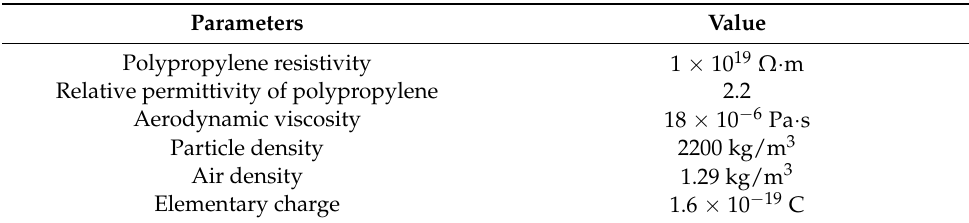
Table 1. Constants used in the single channel simulation.